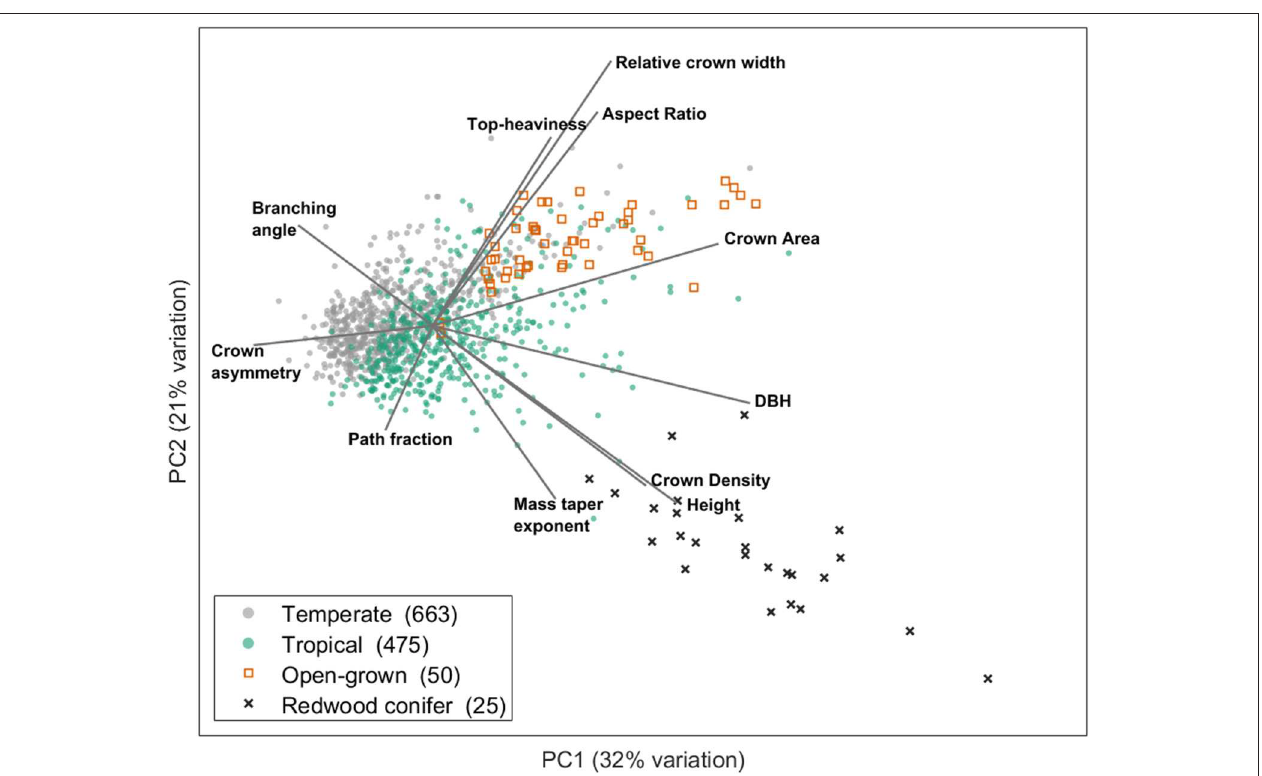
FIGURE 2 | Illustration of how a multidimensional structural trait space can be decomposed in a few dominant axes which form the basis of a structural economics spectrum. This figure is modified from Jackson et al. (2019). The figure shows the two main axes of variation resulting from a principal component analysis executed on structural trait data extracted from cylinder models of TLS 3D point clouds from 1,213 trees from temperate and tropical ecosystems. Only trees taller than 10m were included in the analysis for clarity. The included architectural metrics are: Top-heaviness (ratio of total woody volume in the crown to the stem woody volume), relative crown width (ratio of maximum crown width to tree height), aspect ratio (ratio of maximum crown width to crown height), crown area (maximum ground area covered by the crown viewed from above), DBH (stem diameter at breast height), crown density (ratio of crown area to woody volume in the crown), height (total tree height), mass taper exponent (exponent of a power law fit to the vertical profile of volume), path fraction (ratio of mean to maximum base-to-twig path length), crown asymmetry (the reatio of maximum to mean of 8 angular crown segments) and branching angle (the average angle between two cylinders at each branching point). More information on the underlying data can be found in the original study of Jackson et al.